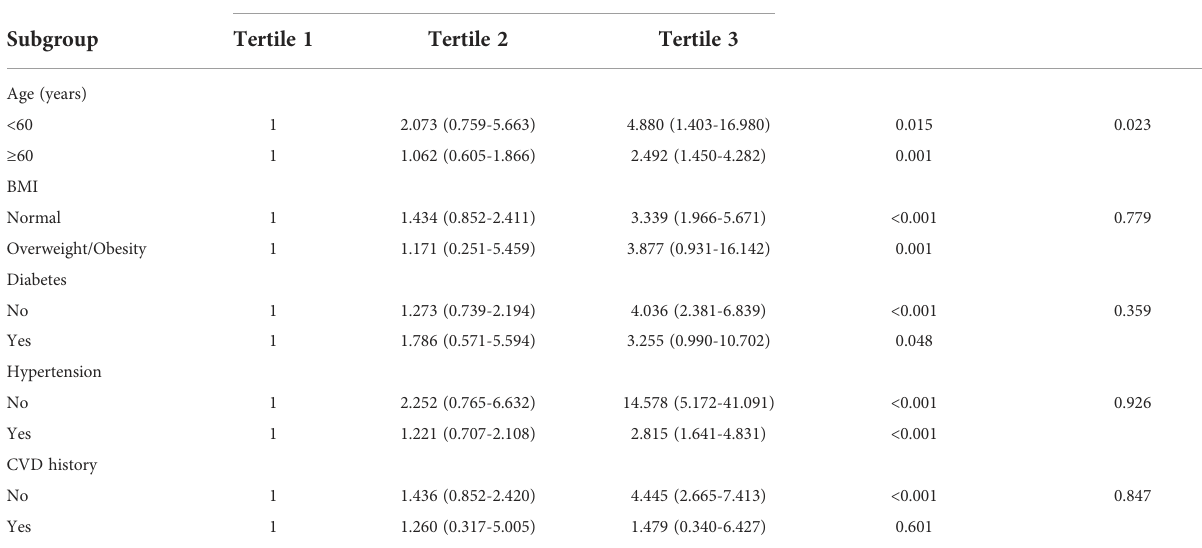
TABLE 3 Subgroup analysis of the association between METS-VF and CKD.